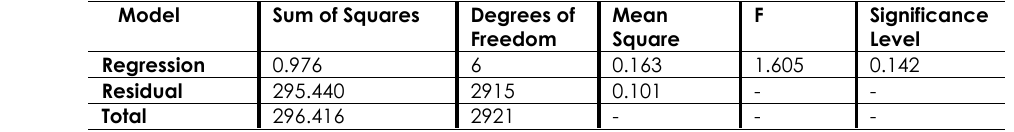
Table 9. Table of variance in the model established to determine whether there is a day effect on